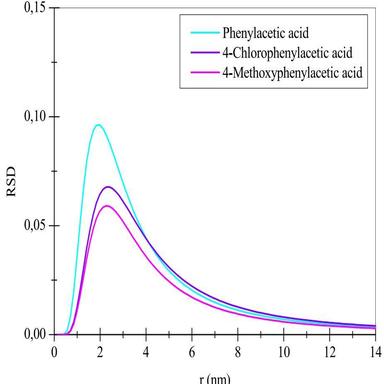
Olfactory receptor site size distributions (RSDs) of the Zebrafish ORA1 activated by phenylacetic acid, 4-chlorophenylacetic acid, and 4-methoxyphenylacetic acid.